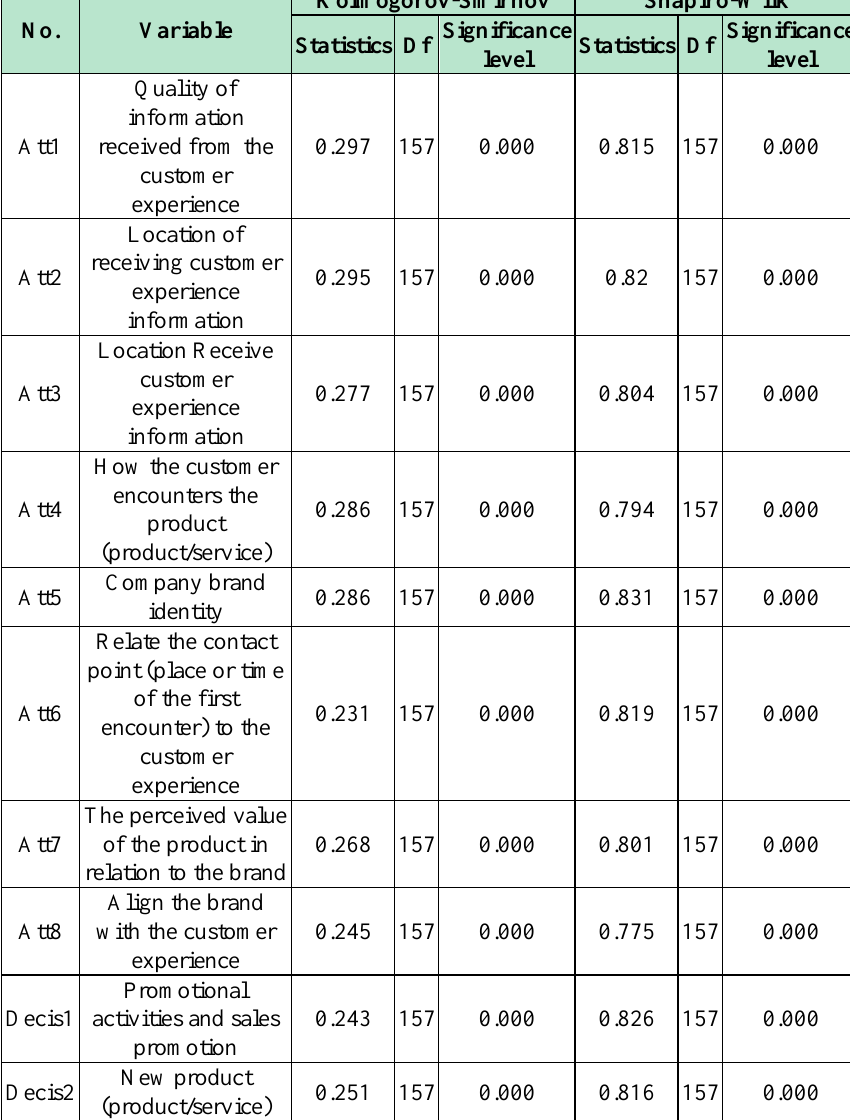
Table 2 - Distribution of scores of